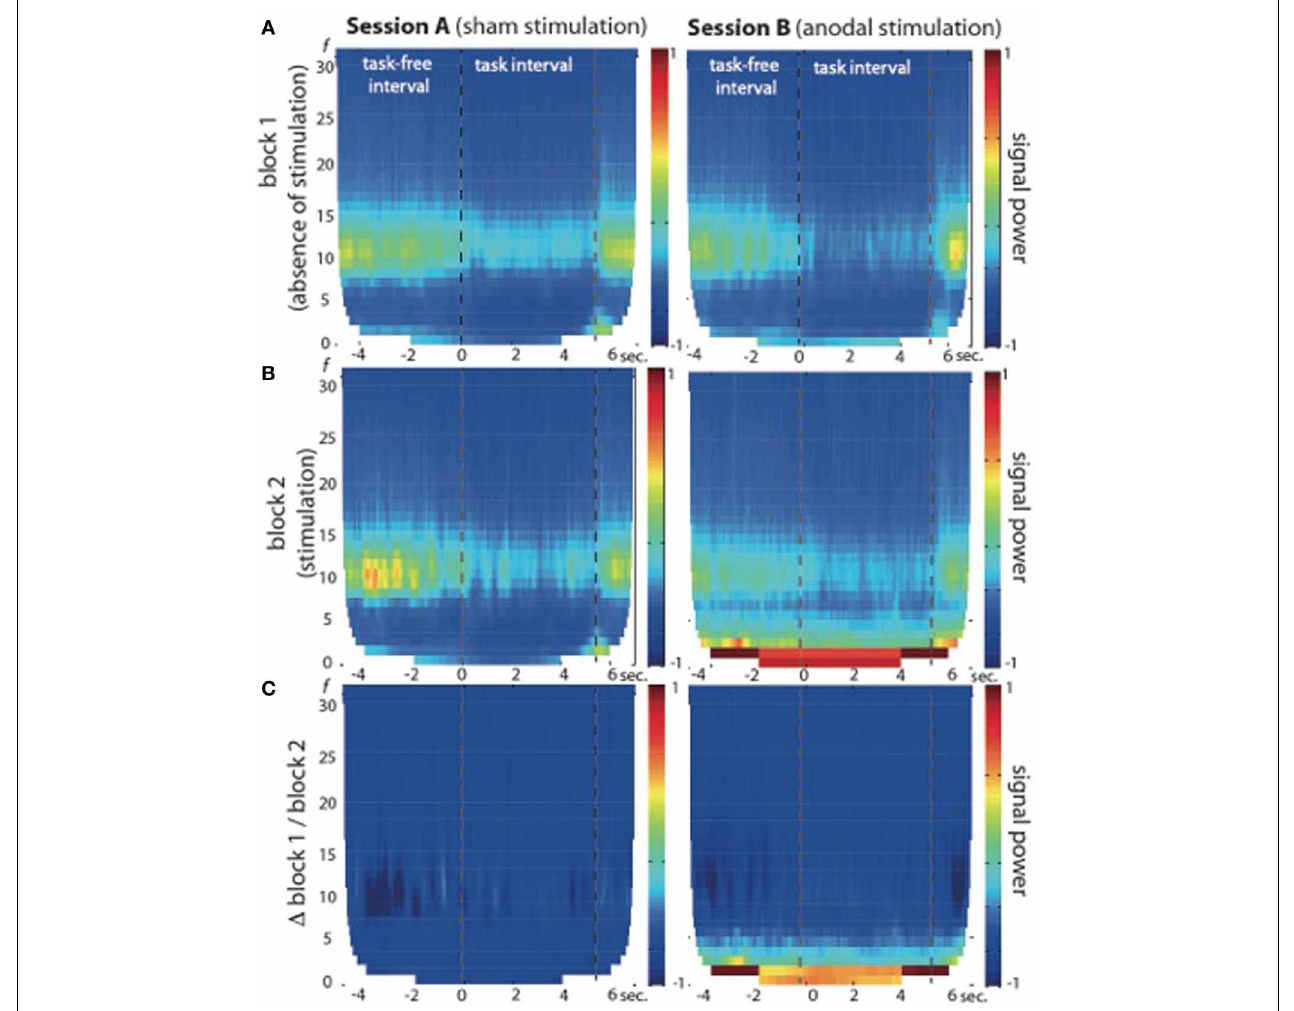
FIGURE 3 | Time-frequency representation (TFR) of brain oscillations recorded from EEG electrode position C4 at 1cm distance from the active electric brain stimulation electrode. (A) Block 1 of session A (left) and session B (right) in absence of electric brain stimulation. (B) Block 2 of session A (left, during sham stimulation) and session B (right, during anodal stimulation). Note the signal